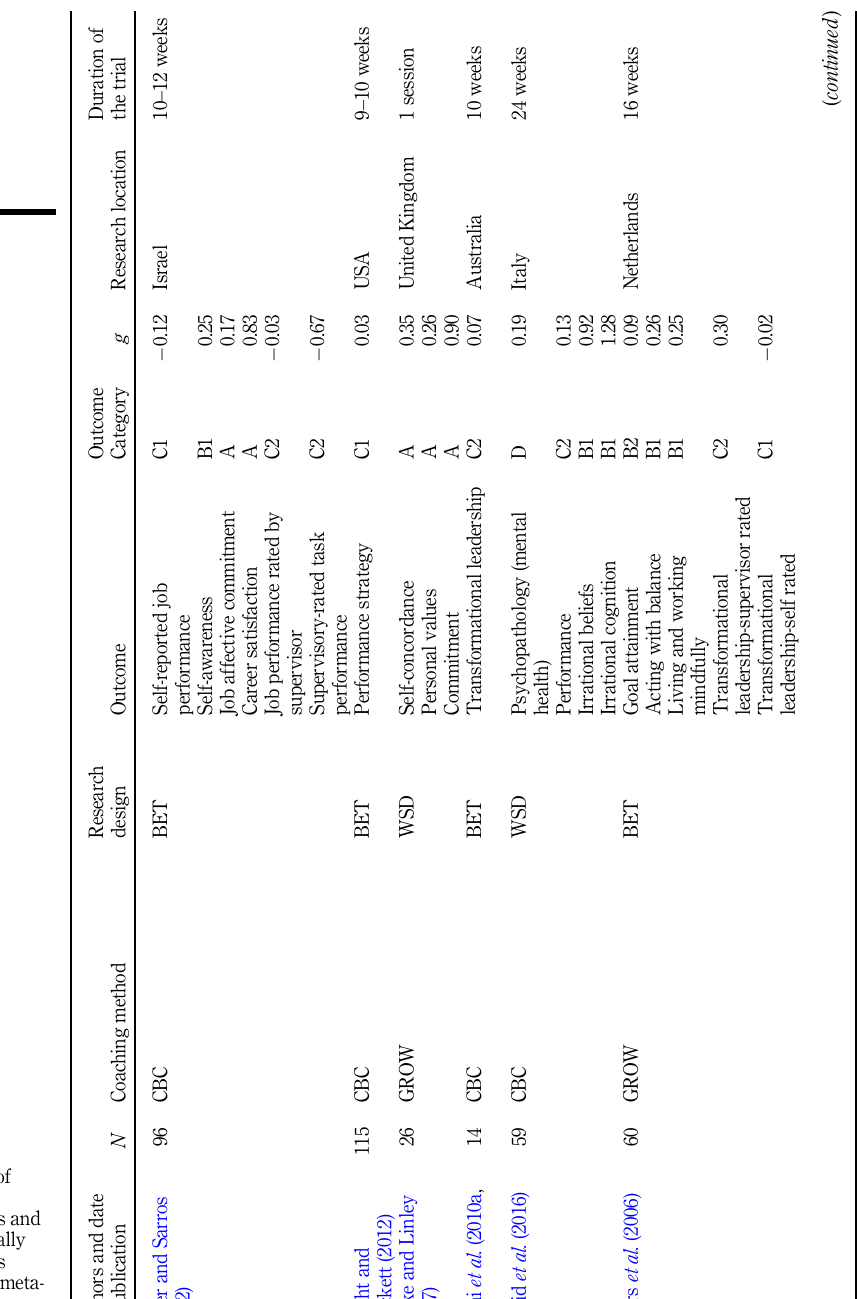
Table 3. Characteristics of psychologically informed studies and nonpsychologically informed studies included in this meta-